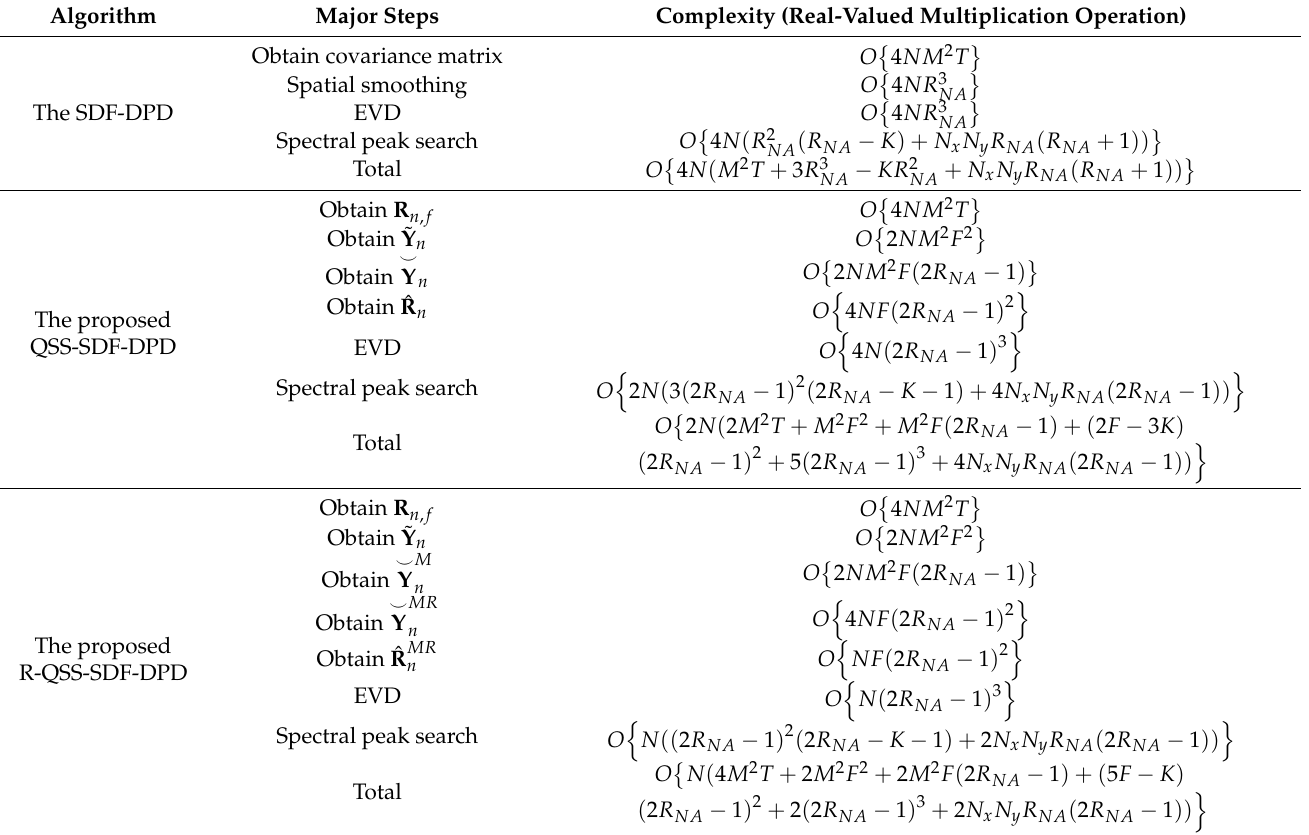
Table 1. Complexity of